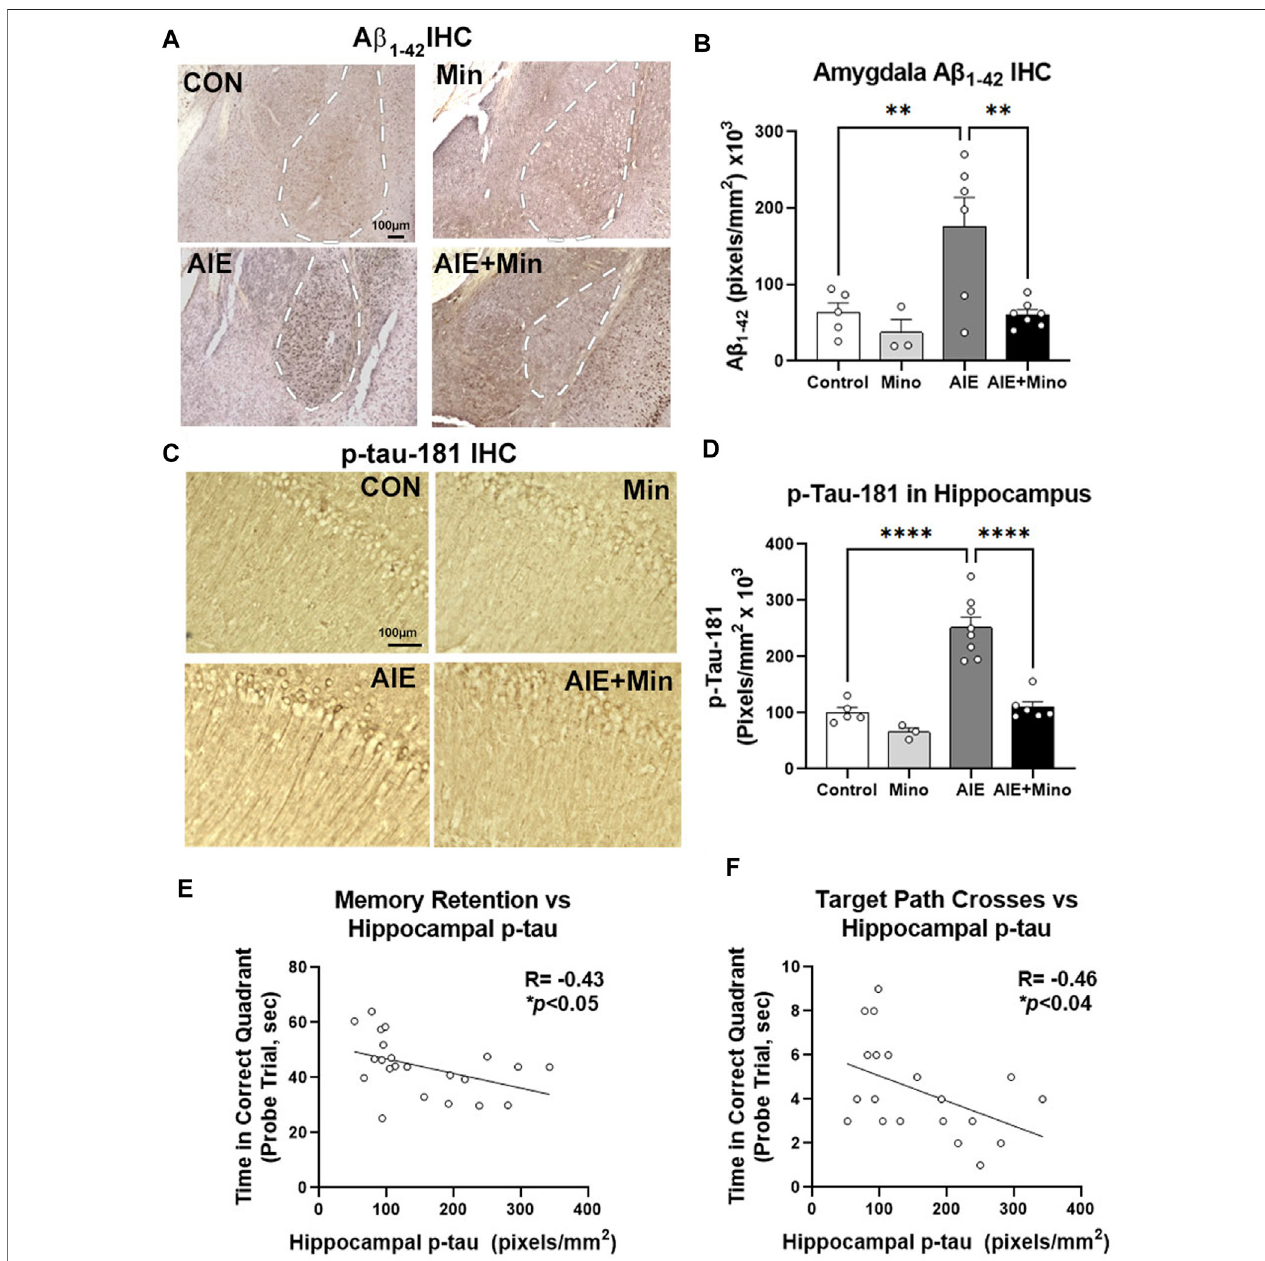
FIGURE 6 | Minocycline reduces AD pathology caused by AIE. 3xTg-AD female mice received either AIE (5 g/kg/day, i.g., 2-days on 2-days off, P25-55) +/ − minocycline (30 mg/kg/d) or water gavage. Mice were assessed for amyloid and tau pathology after behavioral testing in adulthood (P270) by IHC. (A) Representative imagesofintraneuronal A β 1 – 42 stainingin theamygdala(AMG, whitedashed outline). (B) Quanti fi cation ofintraneuronal A β 1 – 42 inAMG founda67%increase byAIEand that was blocked by minocycline. ANOVA F 3,15 = 15.68, p < 0.0001, Sidak ’ s multiple comparison test. N = 5 control, N = 3 control + Mino, N = 6 AIE, N = 7 AIE + mino (C) Representative images of p-tau-181 in the CA1 region of hippocampus. AIE increased staining in cell bodies and dendrites of the CA1. (D) Quanti fi cation of a signi fi cantmaineffectoftreatment(F 3,18 =31.60, p < 0.0001,Sidak ’ spost-test, N =5control, N =3control+Mino, N =8AIE, N =6AIE+mino)witha~2-foldincreasein p-tau-181 by AIE wasblocked by minocycline. (E) A negative correlation between memory retention and hippocampal p-tau IHC was found. R = − 0.43, * p < 0.05. (F) A negativecorrelation betweentarget path crossesintheMWM probetrial and hippocampalp-tau-181 immunoreactivity wasfound. R = − 0.46, * p < 0.04.* p < 0.05, ** p < 0.01 *** p < 0.001, *** p < 0.0001.